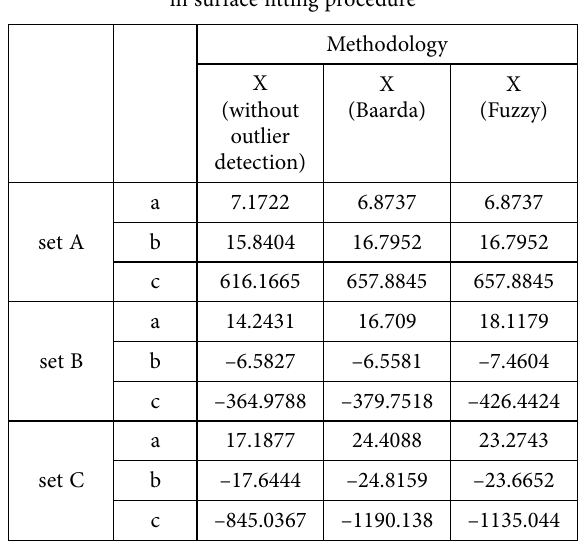
Table 3. Comparison of Baarda method and Fuzzy approach for using LSS to calculate the unknown coefficients in surface fitting